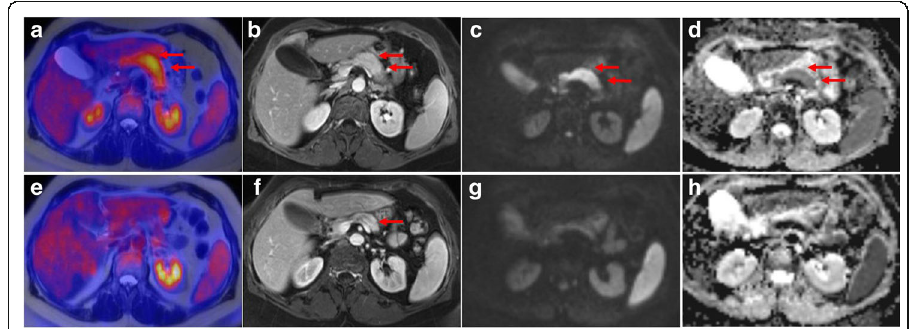
Fig. 1 Multiparametric 18 F-FDG PET/MR in a patient with autoimmune pancreatitis and follow-up 18 F-FDG PET/MR after initiation of steroid